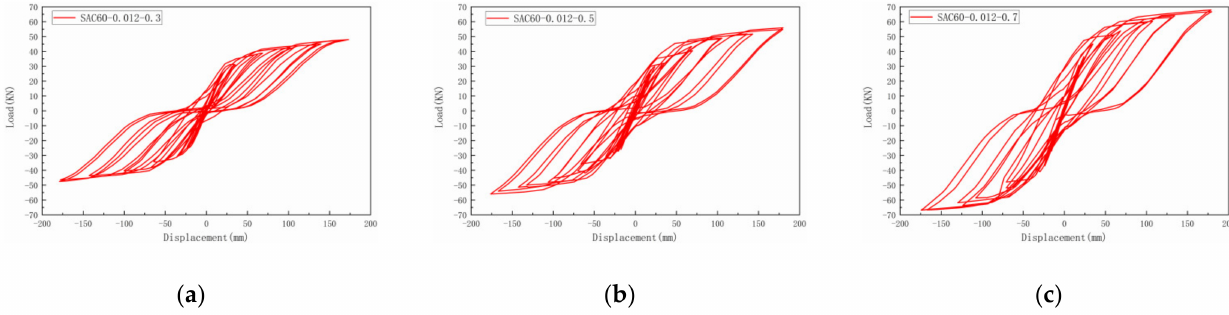
Figure 17. Hysteresis curves with different axial compression ratios, ( a ) Specimen SAC60-0.012-0.3, ( b ) Specimen SAC60- 0.012-0.5, ( c ) Specimen SAC60-0.012-0.7.